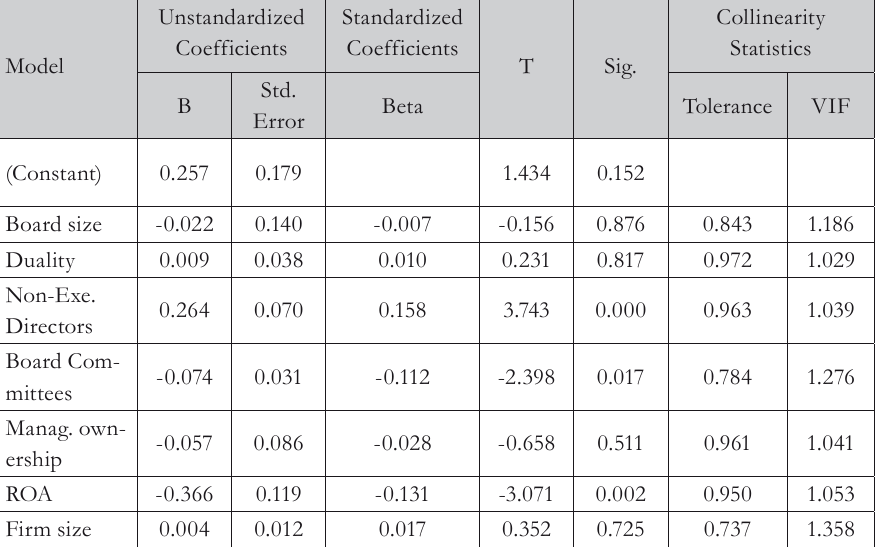
Tab. 6 - Table of Coefficients. Source: Data